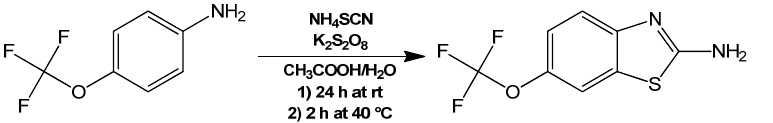
Figure 6. Synthesis of Rlz. The formation of its hydrochloric acid salt for purification (not shown) was carried out from a raw product using HCl and reverted using NH 4 OH.